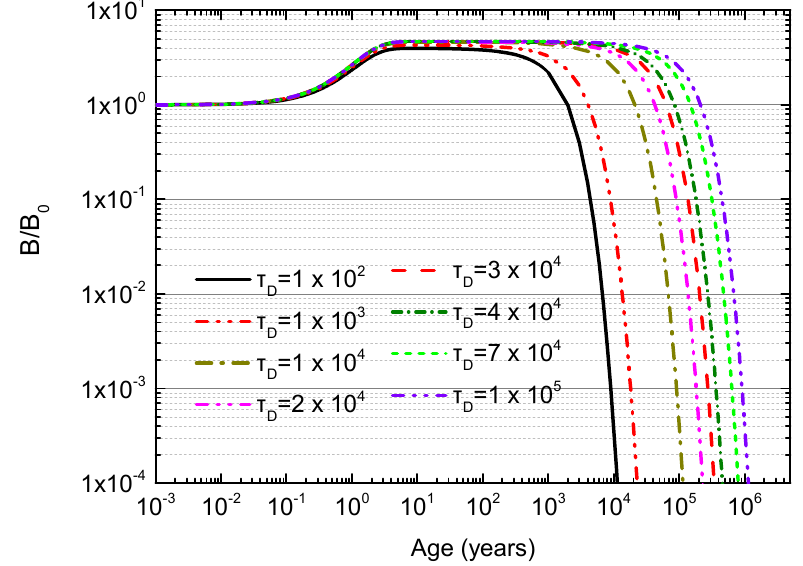
Figure 7. Magnetic field evolution representing the emerging after a hyper-accretion phase followed by the decay of the field. τ D represents the relaxation time of the decay